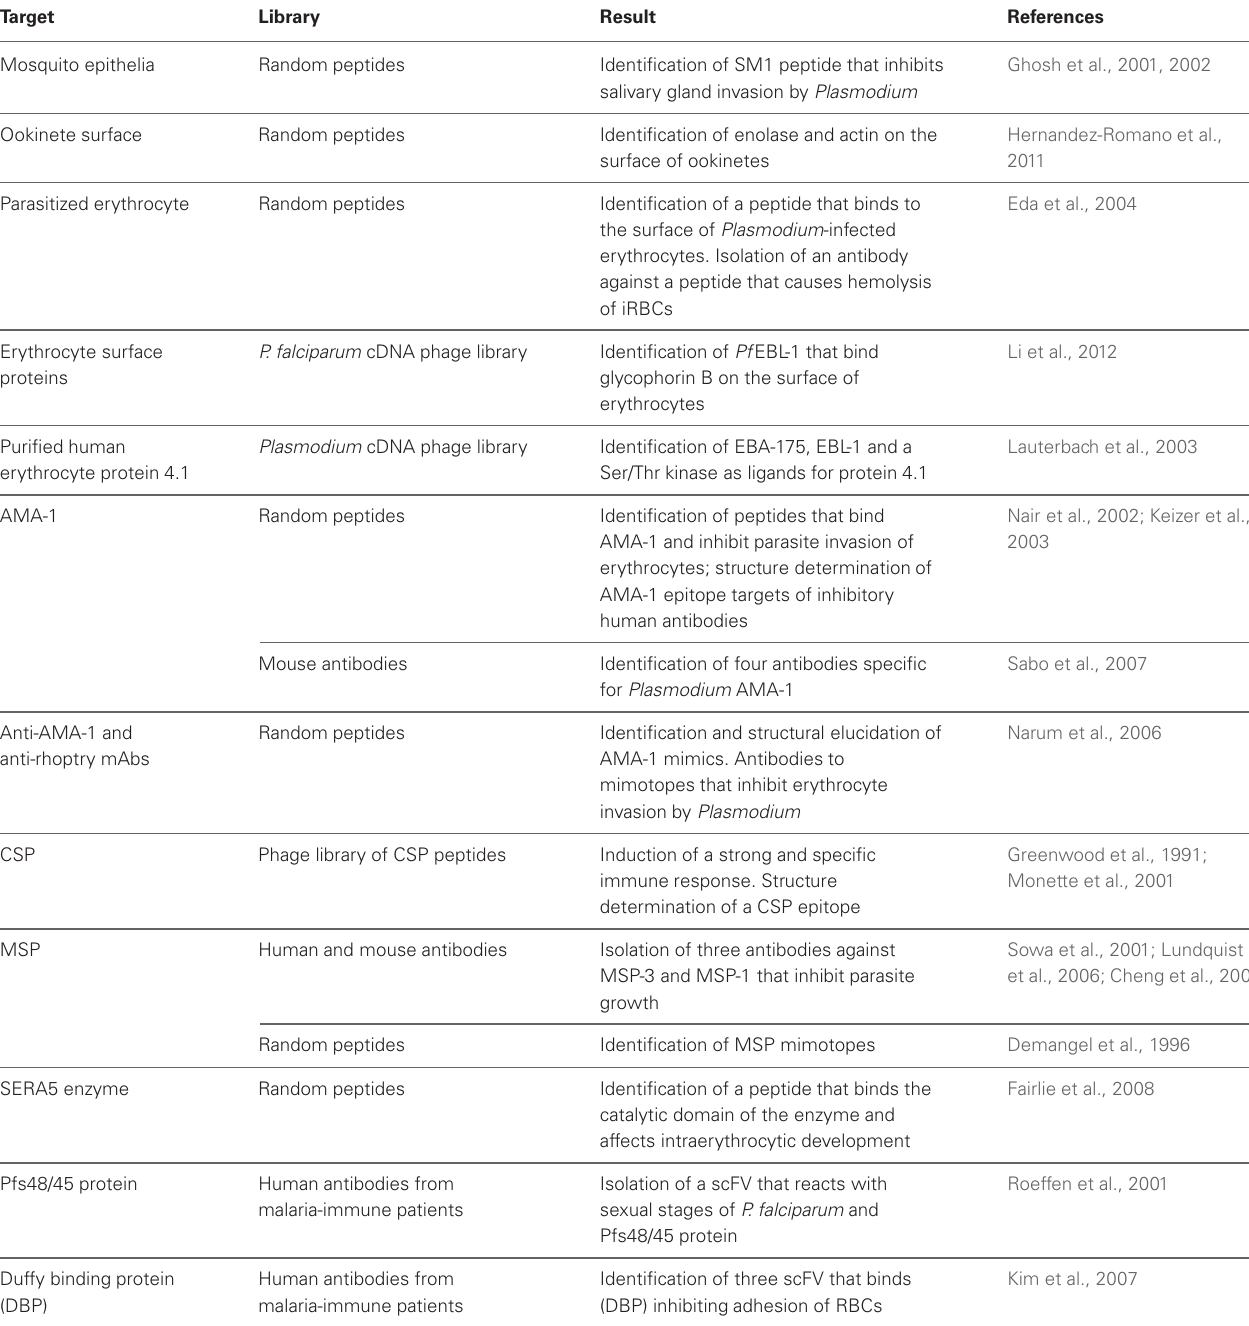
Table 1 | Summary of phage display applications in malaria